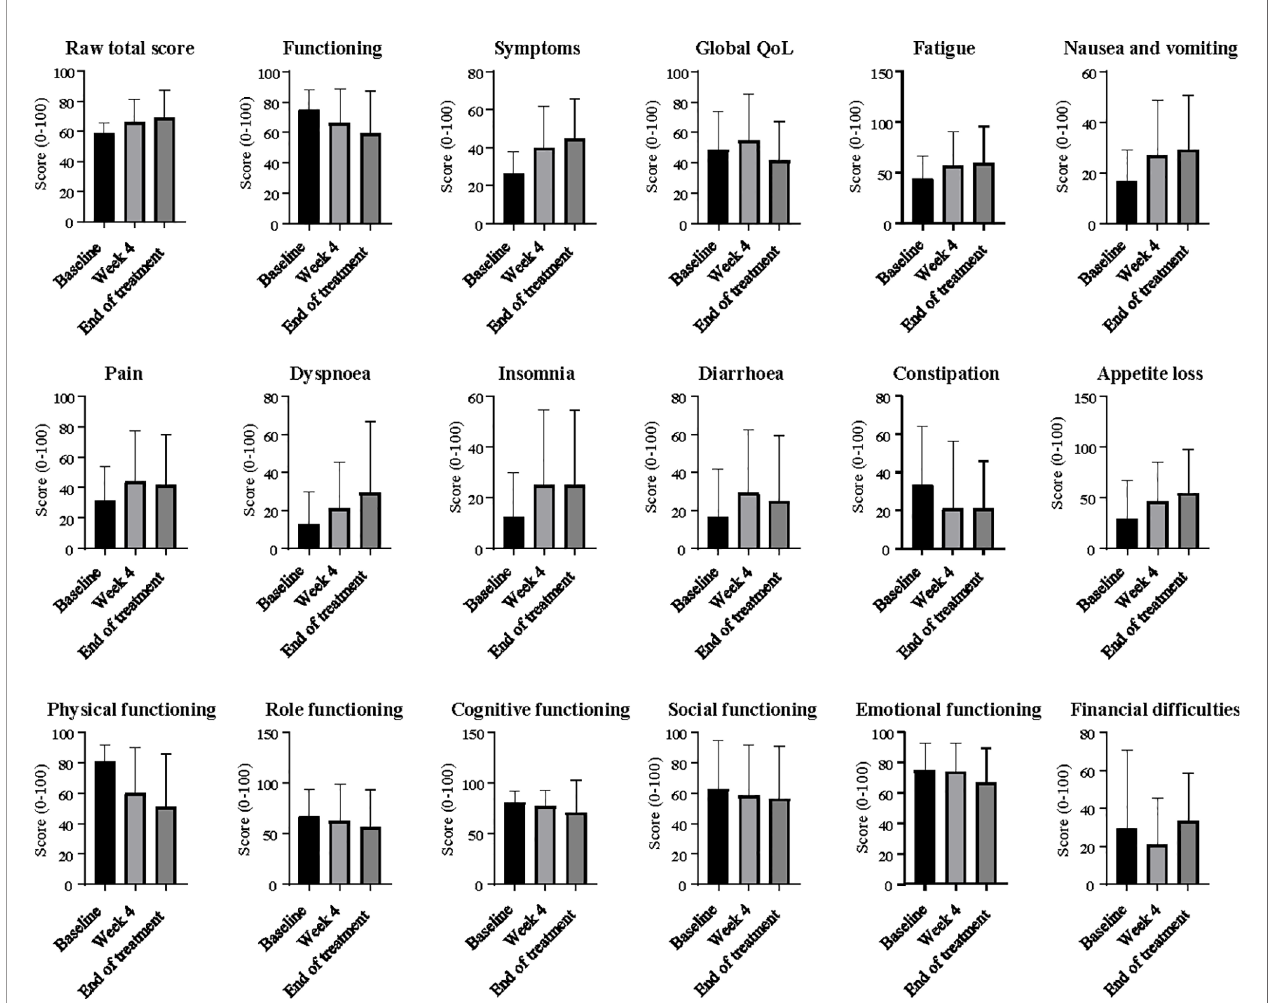
FIGURE 4 | Quality of life scores at baseline, week 4 and end of treatment. Ordinary one-way ANOVA and Tukey ’ s multiple comparisons test were used to compare differences between timepoints. Error bars on column graphs represent the standard deviation from the mean. No signi fi cant changes from baseline were seen in any scores.